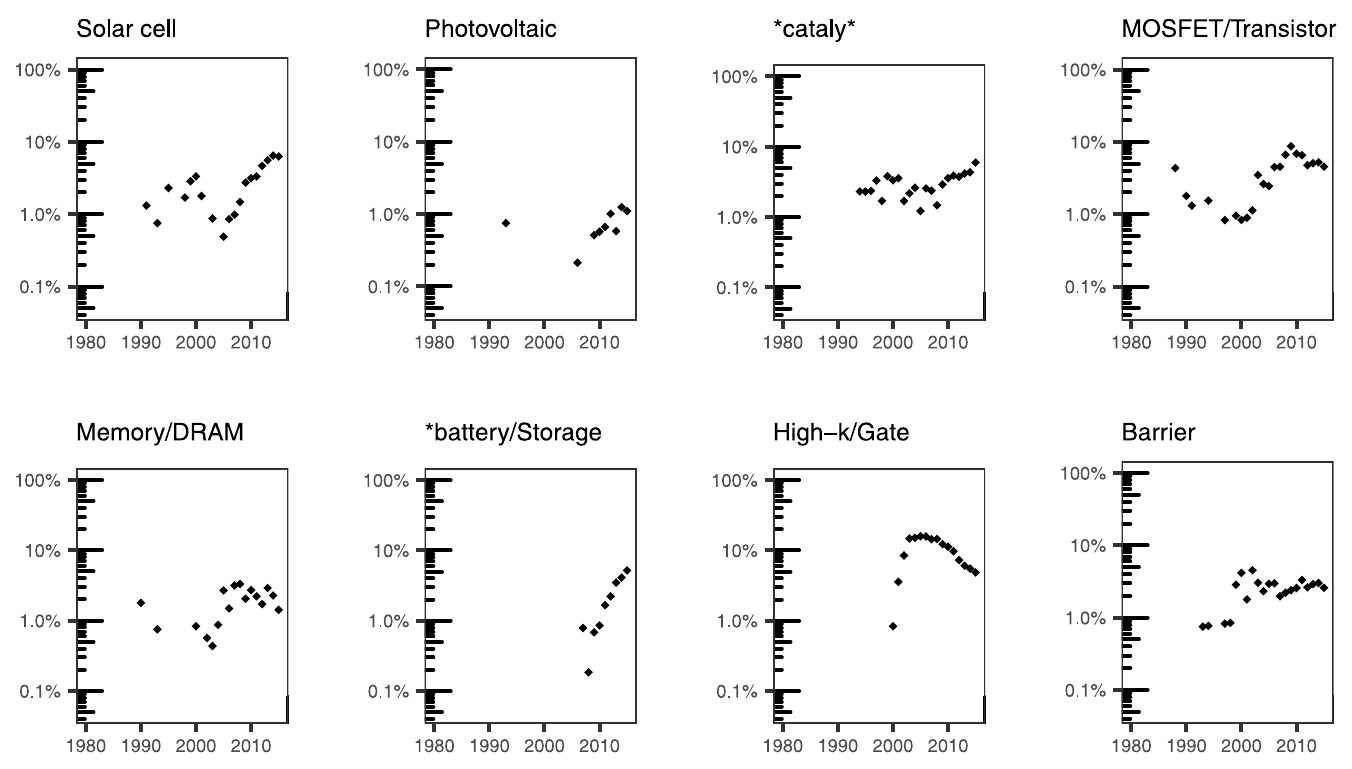
Fig 10. Percentage of ALD papers containing a specific word pertaining to applications of in their titles.